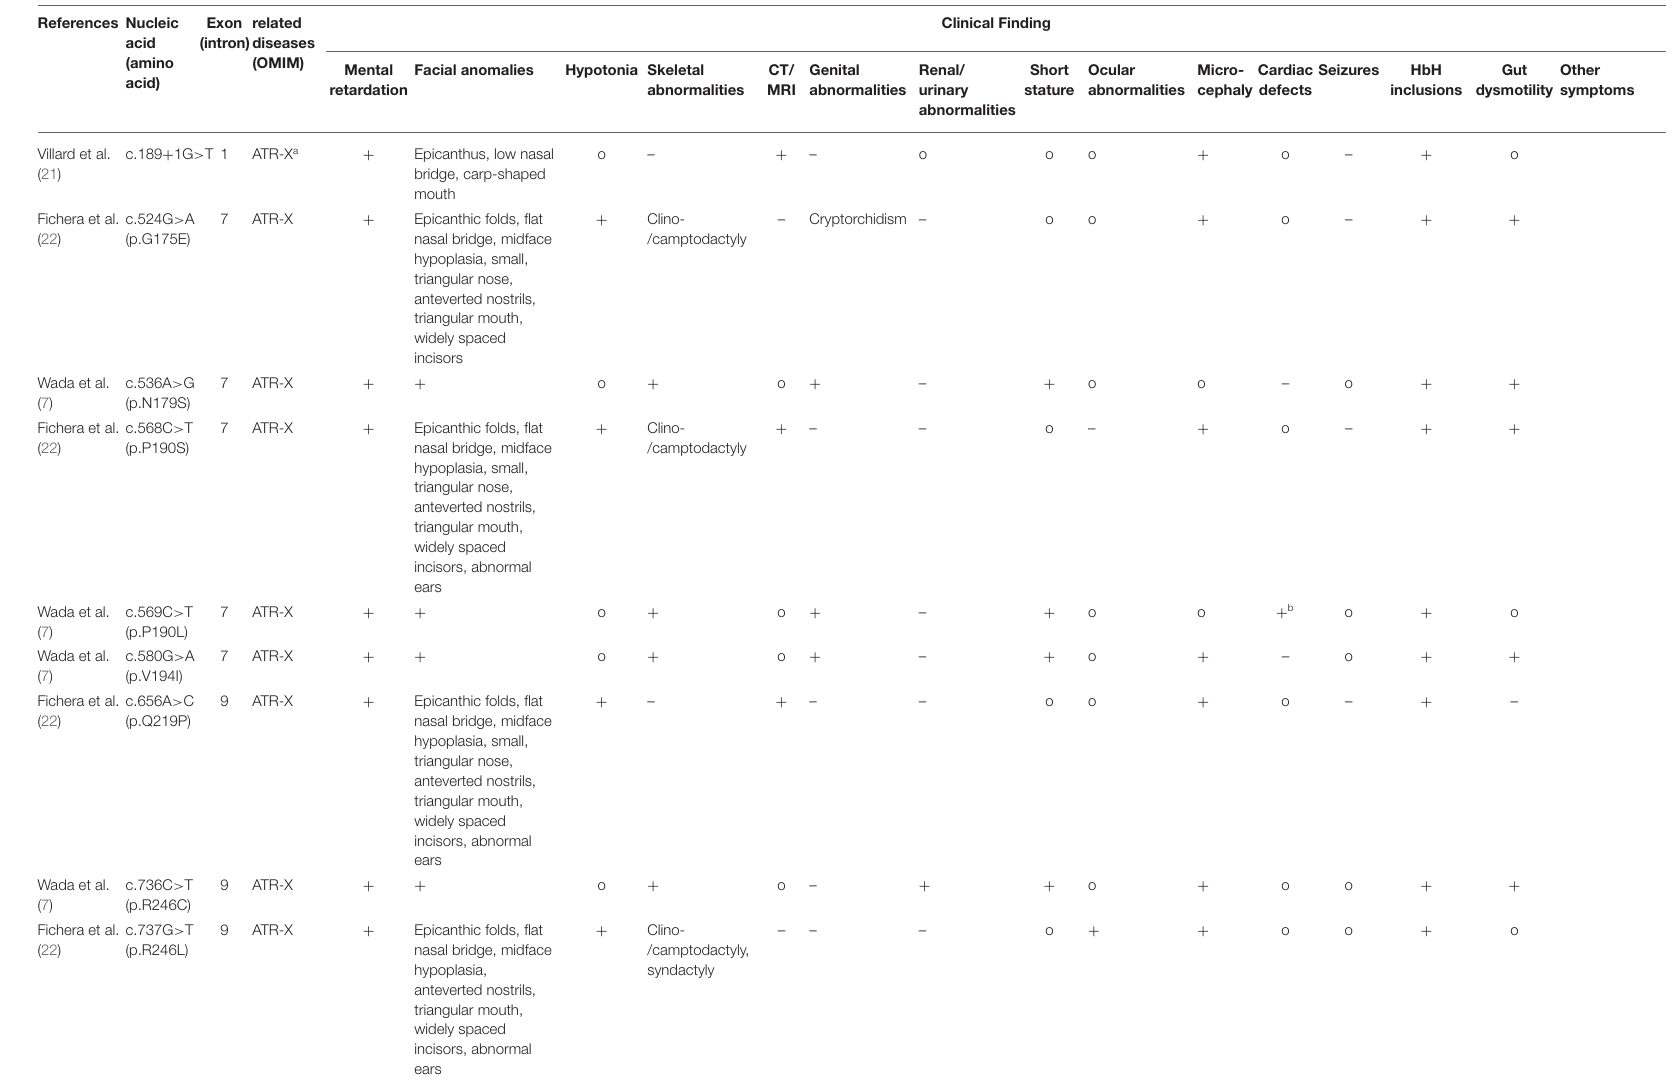
TABLE 2 | Previously reported cases carrying ATRX variants with alpha-thalassemia. References Nucleic